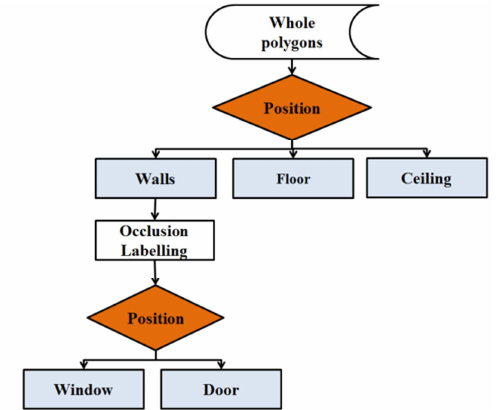
Figure 8. Hierarchical classification tree, orange diamonds are conditions while blue rectangles represent room elements.